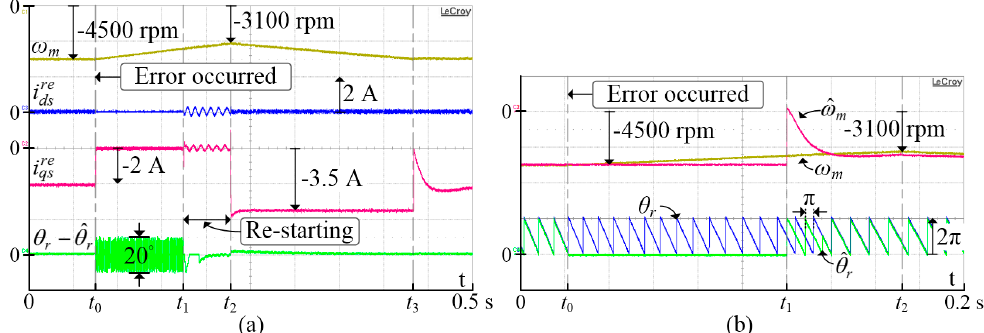
Figure 16. ( a ) Restarting of the motor from θ r = 90° with a positive speed under the rated load; ( b ) Amplified waveforms.